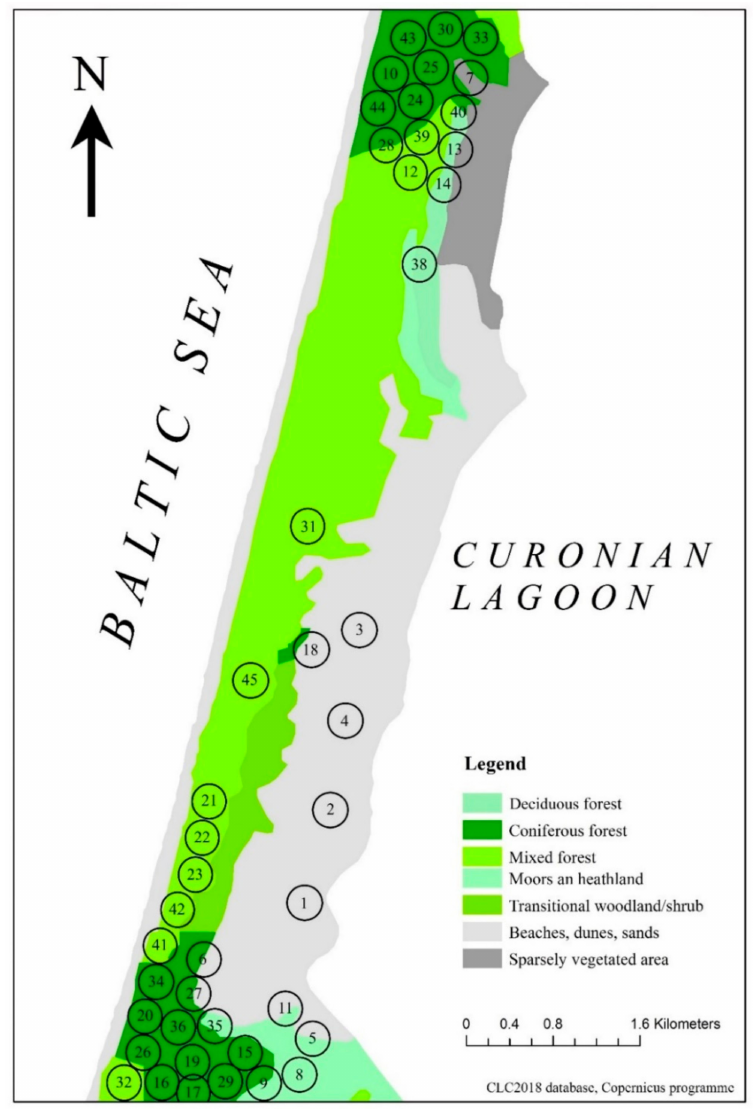
Figure 2. Locations of the sites for taking photos (the numbers refer to the habitats from Table